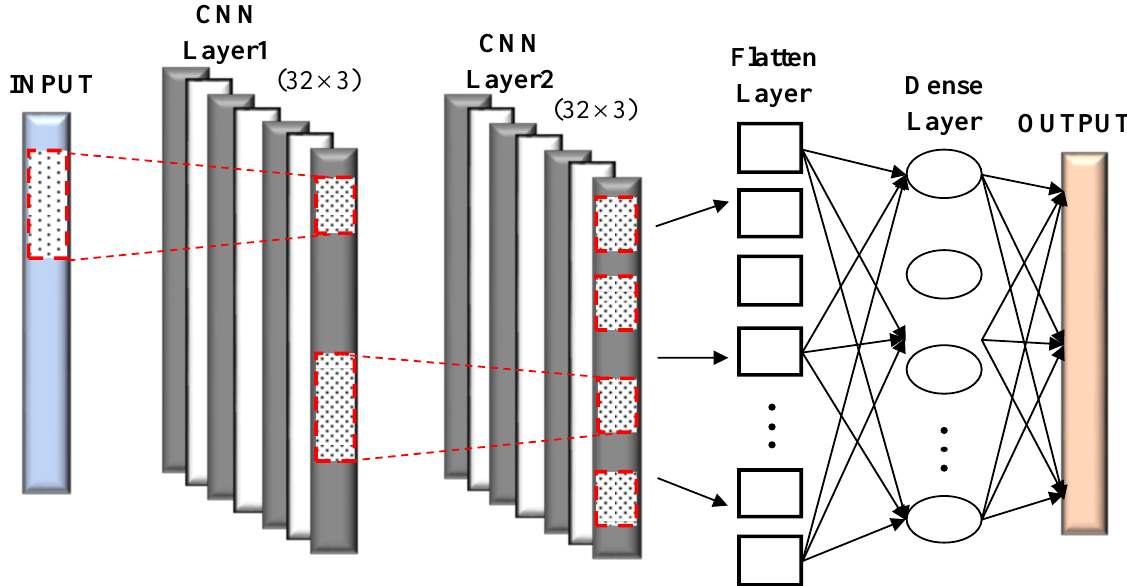
Figure 3. Network structure diagram of CNN-based seismic inversion.